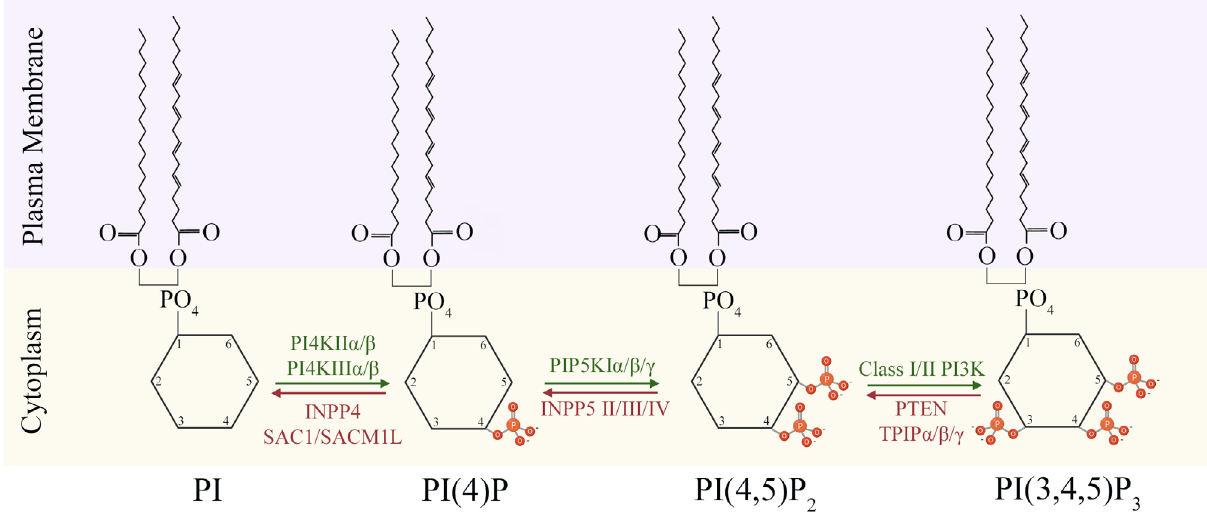
and PIP at plasma membrane-cytoplasm interface. The equilibrium between synthesis of PIP Figure 1. Biosynthesis of PIP 2 3 and PIP at membrane-cytoplasm interface is maintained through addition of phosphate groups (orange) by kinases (green), 3 and its removal by phosphatases (red) at position 3,4, or 5 of the cytoplasmic inositol head group of phosphoinositides (PI). INPP4: inositol polyphosphate 4-phosphatase; SACM1L: SAC1 like phosphatidylinositide phosphatase; INPP5: inositol polyphosphate 5-phosphatase; TPIP: transmembrane phosphatase with tensin homology (TPTE) and PTEN homologous inositol lipid